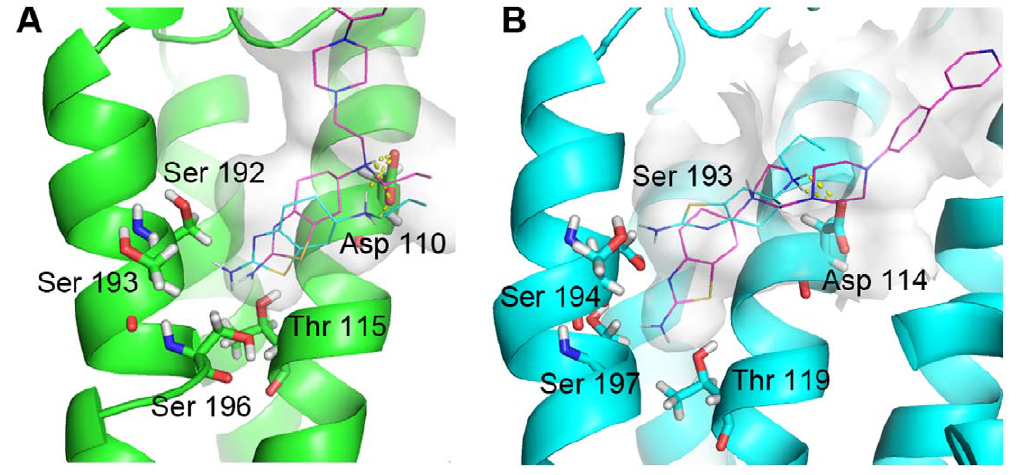
Figure 8. Virtual screening. Pose of pramipexole (cyan lines) and compound ZINC45254546 (magenta lines, see also text) docked into hD 3 (A) and hD 2L (B) optimized receptor structures. H-bonds with Aspartate conserved residues are represented with yellow dashes.